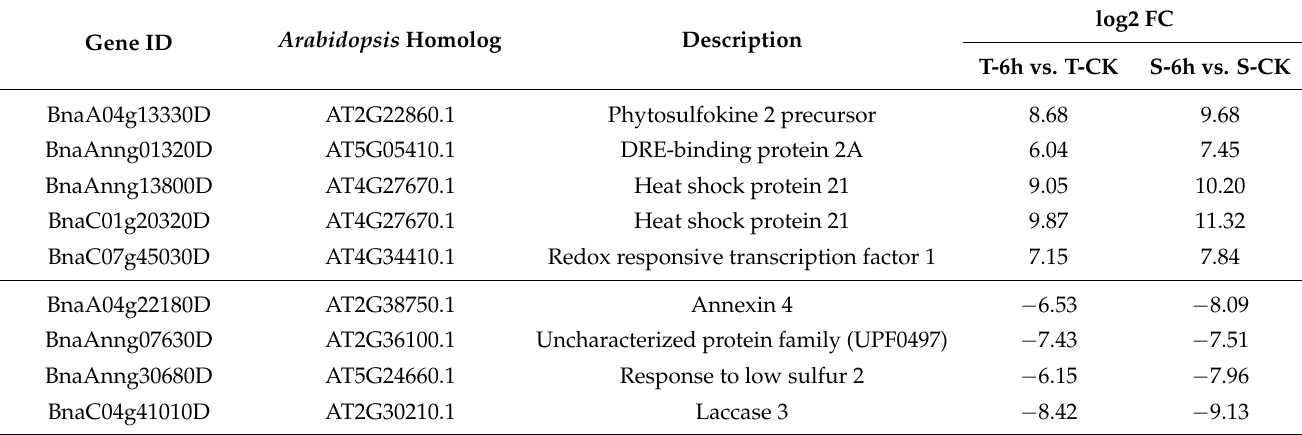
Table 1. Synchronously up-/ down-regulated genes within top 20 DEGs in flooding response.